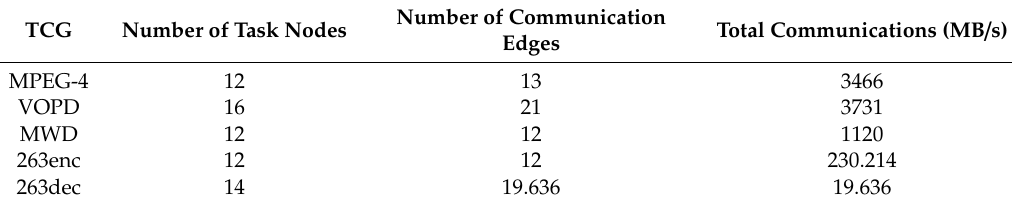
Table 4. Attributes of task communication graph.